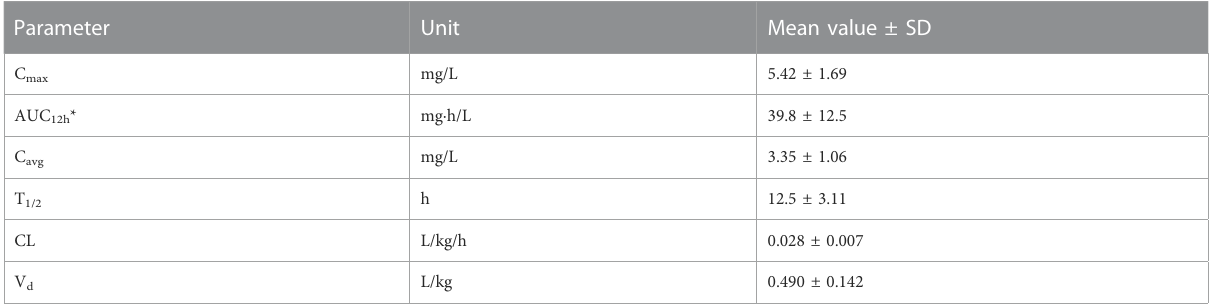
TABLE 4 Pharmacokinetic parameters by non-compartmental analysis.